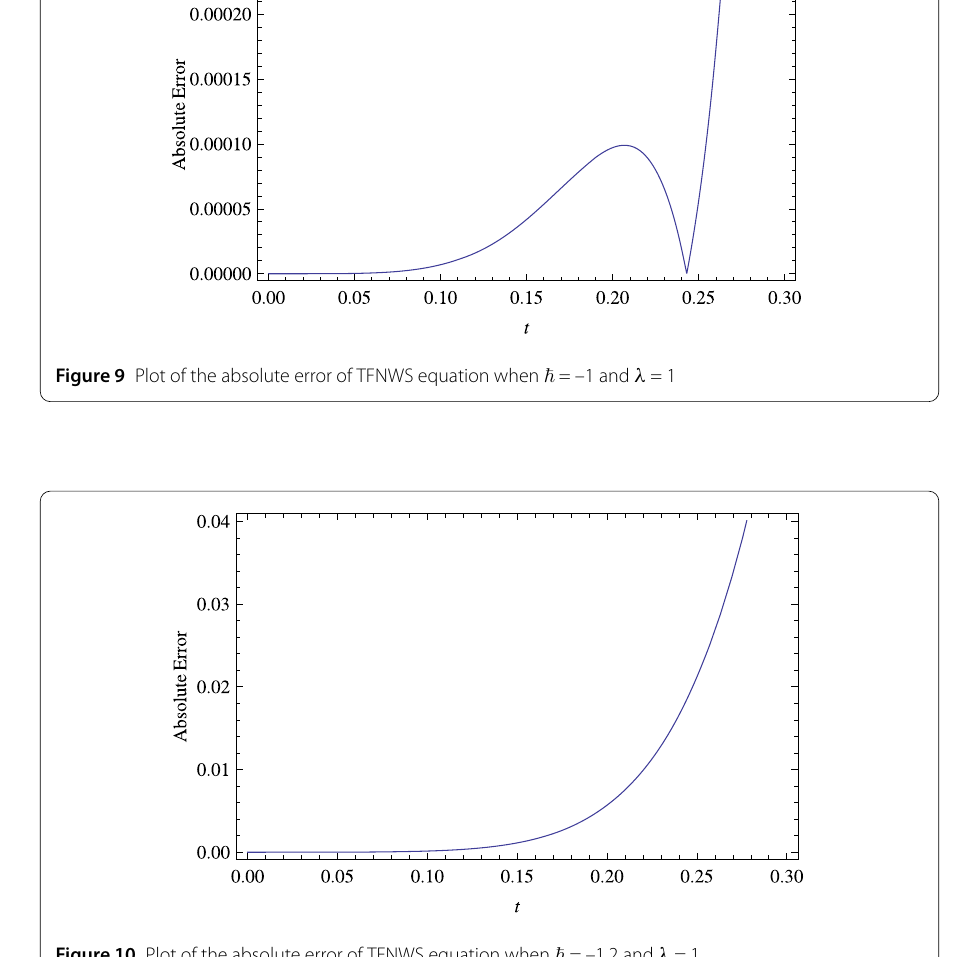
Figure 10 Plot of the absolute error of TFNWS equation when (cid:2) = –1.2 and λ = 1